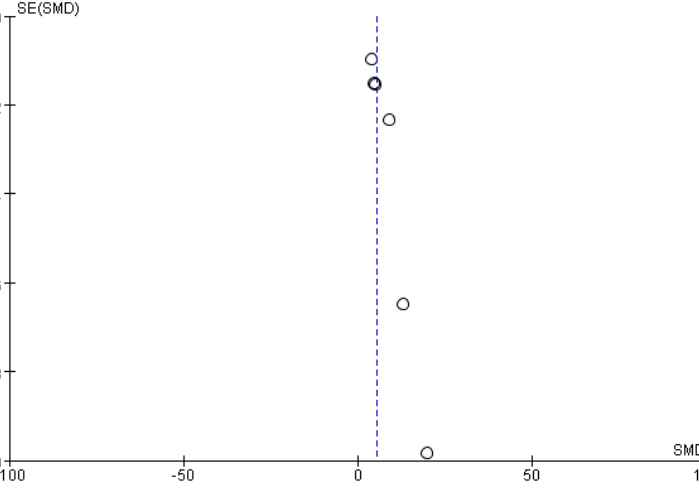
Figure 16. Funnel plot of studies assessment anti-inflammatory activity of S. crispa.